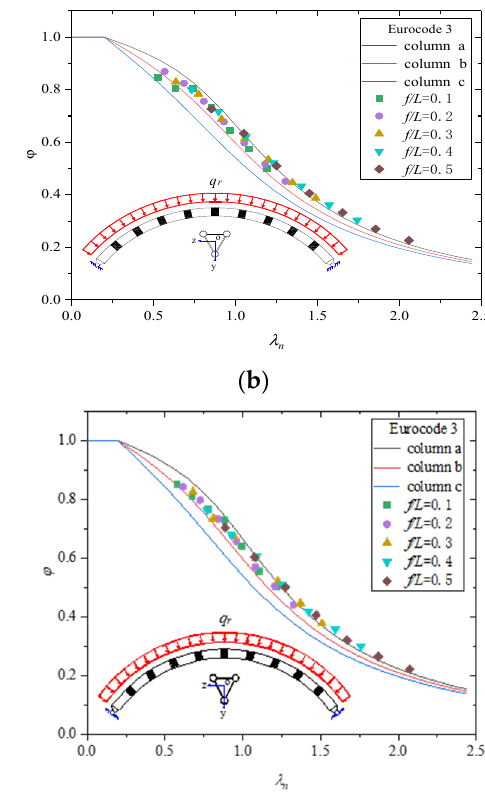
Figure 12. Stress distribution of the arch at point A on the curve (Pa).